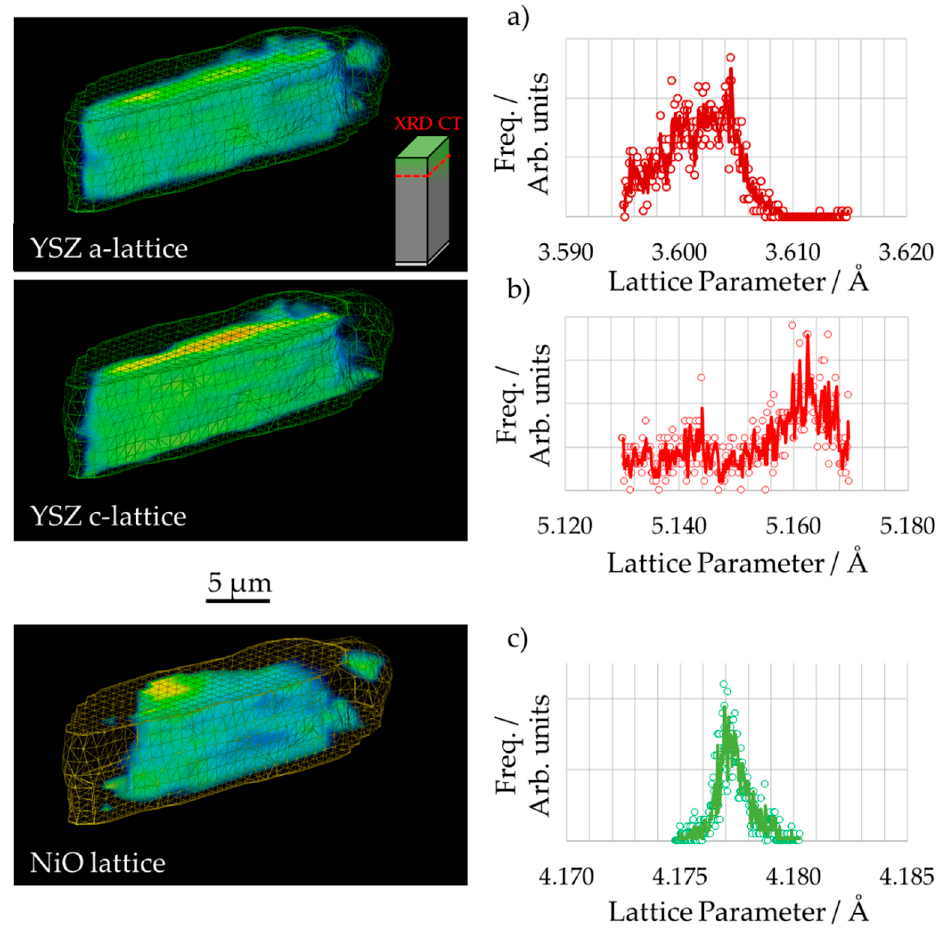
Figure 4. Data on the lattice parameters for ( a ) YSZ a-lattice, ( b ) YSZ c-lattice, and ( c ) NiO lattice. The 3D lattice parameter maps are enclosed by an exoskeleton (yellow mesh) that was generated using correlative lab-based TXM data. The 3D volumes are accompanied by lattice parameter histograms. The dashed red line within the diagram of the SOFC sample indicates the region that was imaged.